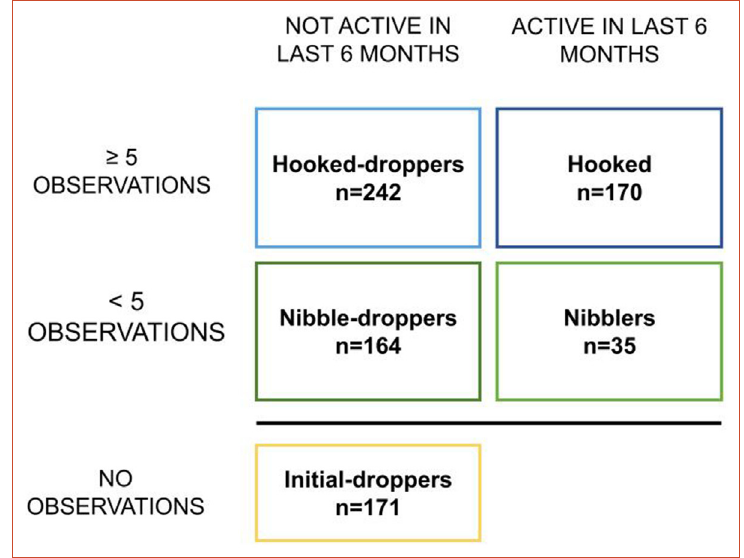
Figure 4 A grid showing how GLOBE Observer participants were grouped into Nibble-and-Drop Framework categories. Sample sizes indicate the number of survey participants who fell into each category according to the metrics chosen—fewer than five observations versus five or more observations, and activity within the past six